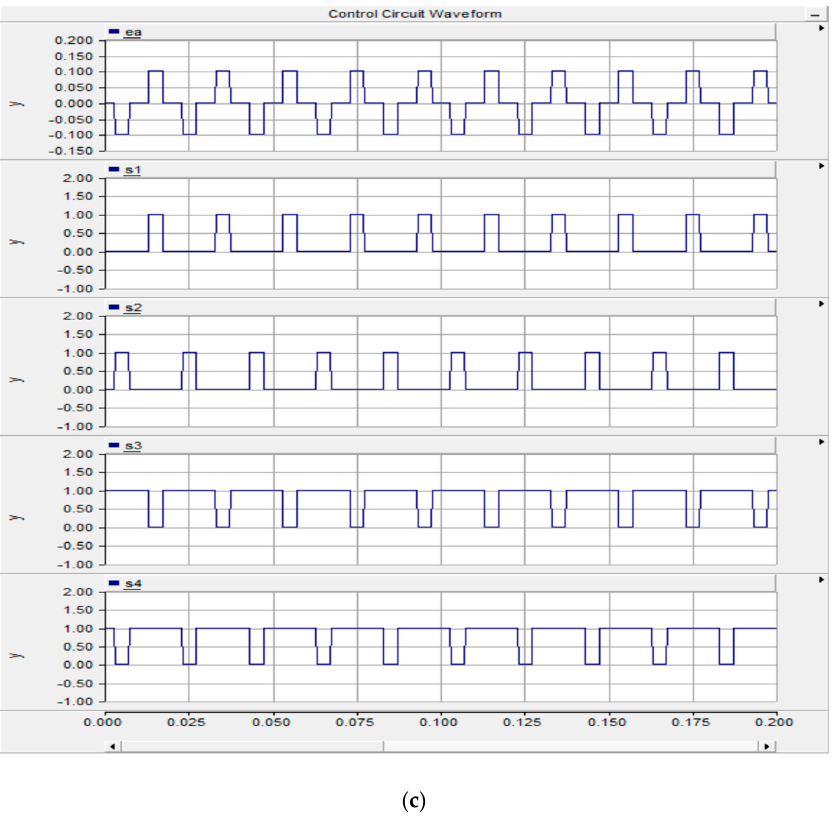
Figure 7. ( a ) Power circuit of 3- level CHB-MLI; ( b ) control circuit of 3- level CHB- MLI; ( c ) phase output voltage waveform of 3-level CHB-MLI. Table 3. Voltage levels of 3-level cascade H-bridge multilevel inverter and switching states.